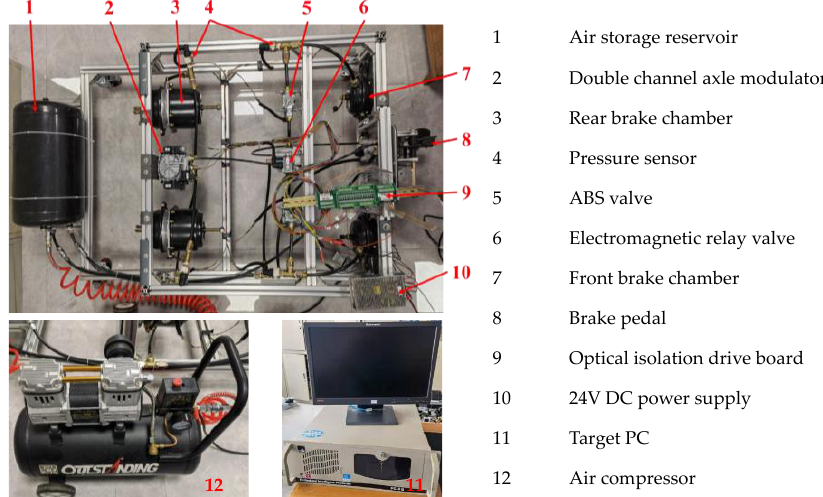
Figure 18. Physical display of the test platform.